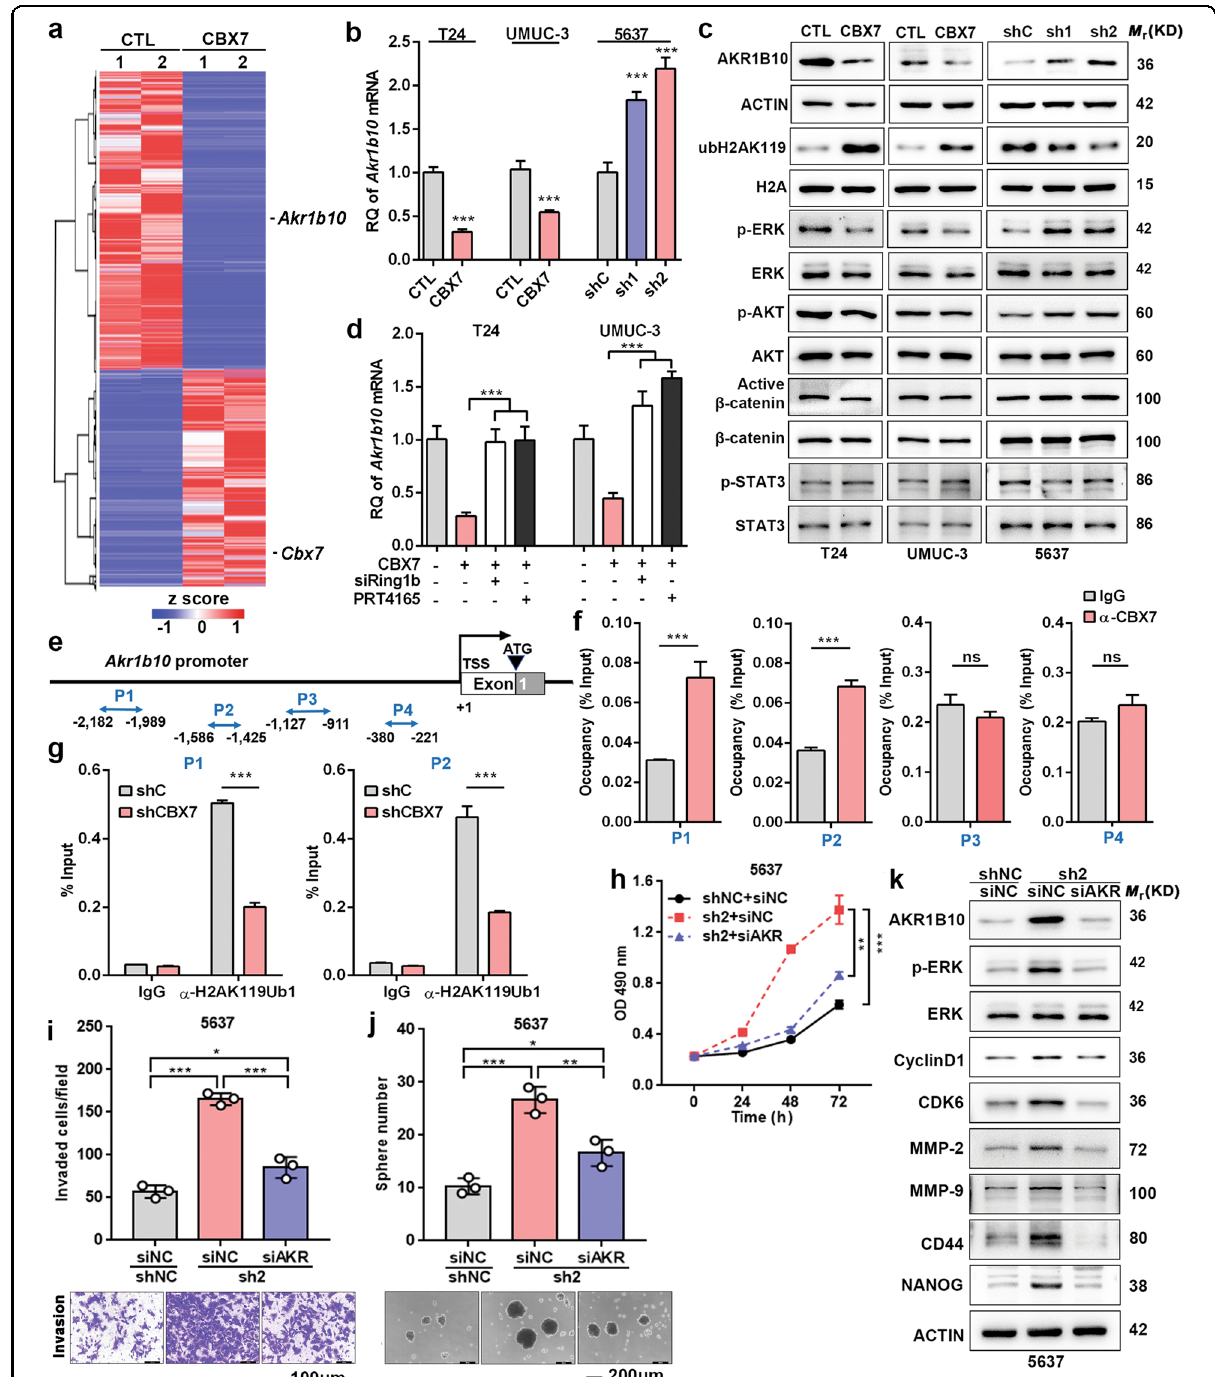
Fig. 5 CBX7 suppresses UBC progression via suppression of AKR1B10 in a PRC1-dependent manner and thereby inhibits ERK signaling. a RNA transcriptome sequencing analysis was performed to examine the altered expression of genes by CBX7 overexpression in T24 cells. b AKR1B10 mRNA expression level upon CBX7 overexpression or knockdown. c Western blotting was performed to detect genes expression upon CBX7 overexpression or knockdown. d Cells with CBX7 overexpression were treated with Ring1b siRNA or RING inhibitor PRT-4165 for 24 h. The mRNA expression of AKR1B10 was determined by qRT-PCR. e A schematic representation of the AKR1B10 promoter studied by ChIP analysis. f Quantitative ChIP analysis of CBX7 in AKR1B10 in 5637 cells. g Quantitative ChIP analysis of H2AK119ub1 in AKR1B10 in 5637 CBX7-silenced cells. h – j CBX7 knockdown increased cell viability, invasive ability, and the size and number of spheres in 5637 cells, whereas this effect was partly abolished upon AKR1B10 suppression (AKR means AKR1B10). Scale bar, 100 μ m ( i ); 200 μ m ( j ). k Western blotting was used to examine genes expression in CBX7 knockdown 5637 cells transiently transfected with siNC and siAKR1B10. Data are presented as means±SD from three independent replicates. * p <0.05, ** p <0.01, *** p